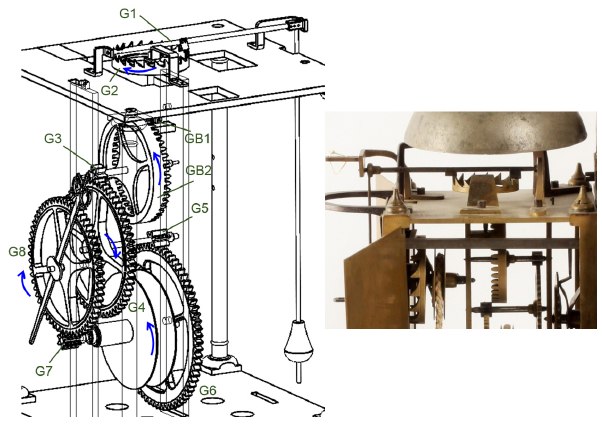
Figure 25. Structure and operation of the N9 going system (Artlistings, 2022b). (The photograph is an illustration of a similar type.)